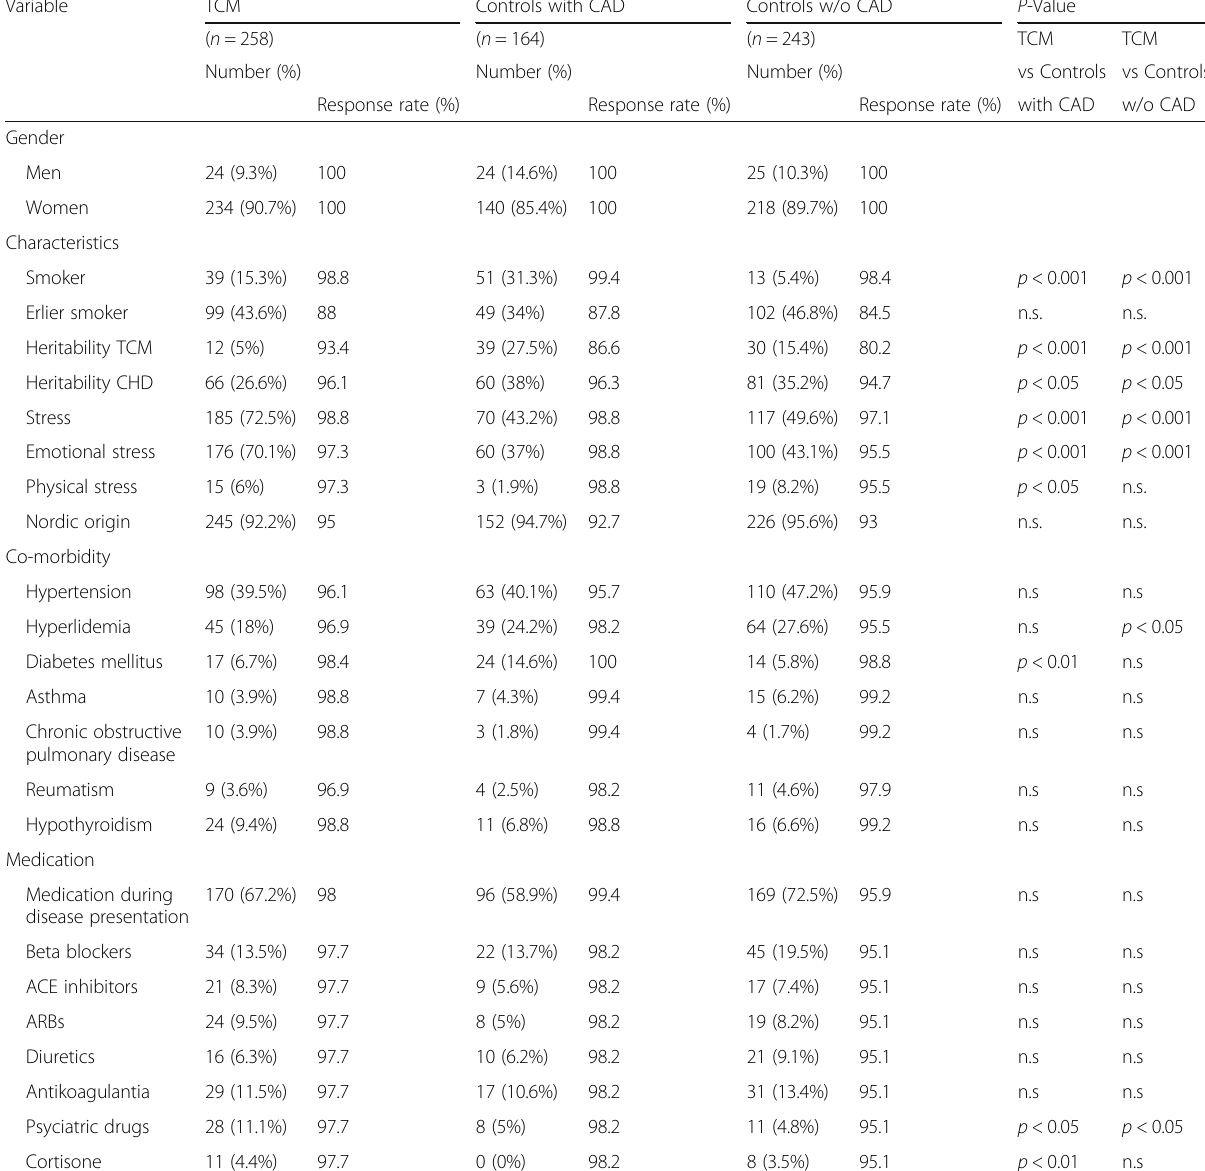
Table 1 Frequencies of patient characteristics and Pearsons or Fishers chi-square test of association between each characteristic and takotsubo cardiomyopathy in 258 patients with Takotsubo cardiomyopathy and sex and age-matched controls with and without coronary artery disease Variable TCM Controls with CAD Controls w/o CAD P